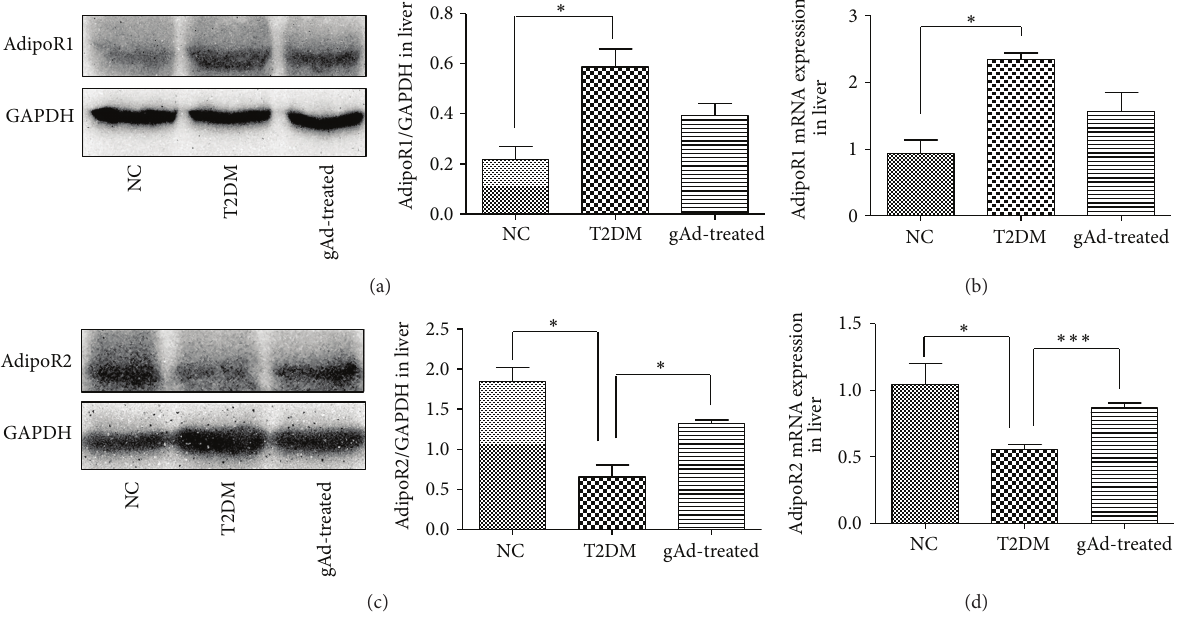
Figure 3: (a) Relative adipoR1 protein expression in liver was determined through western blotting using GAPDH as a reference protein. (b) Relative adipoR1 mRNA expression in rat liver. (c) Relative adipoR2 protein expression in liver was determined through western blotting using GAPDH as a reference protein. (d) Relative adipoR2 mRNA expression in rat liver. ∗ 𝑃 < 0.05 , ∗∗∗ 𝑃 < 0.001 as compared to T2DM group.